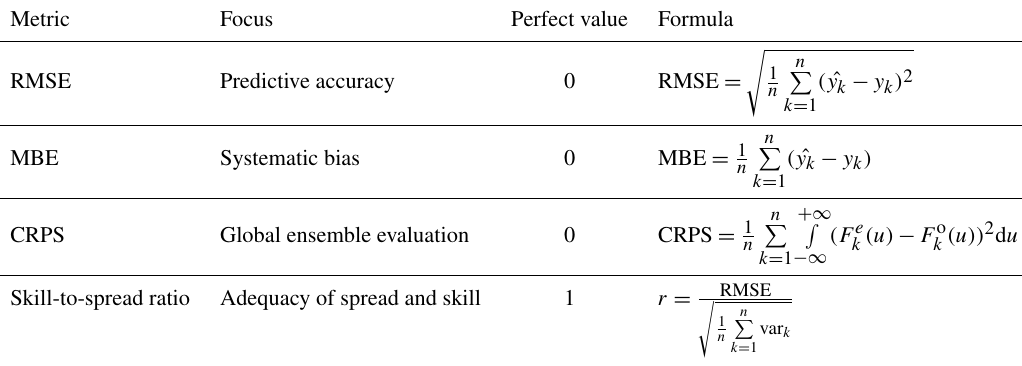
Table 1. Performance metrics.